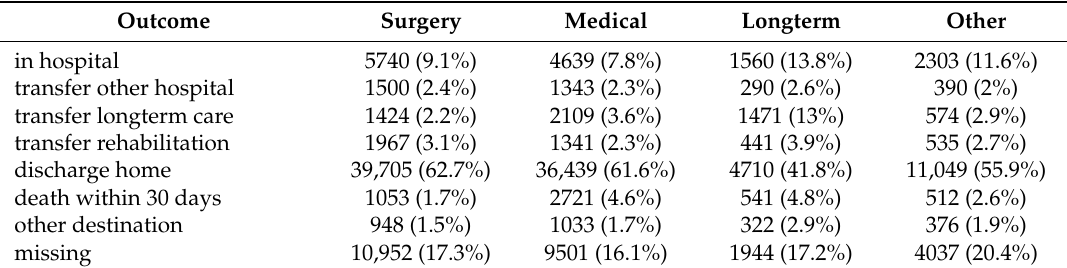
Table 4. Outcomes in hospital within 30 days after nutritionDay in the four patient